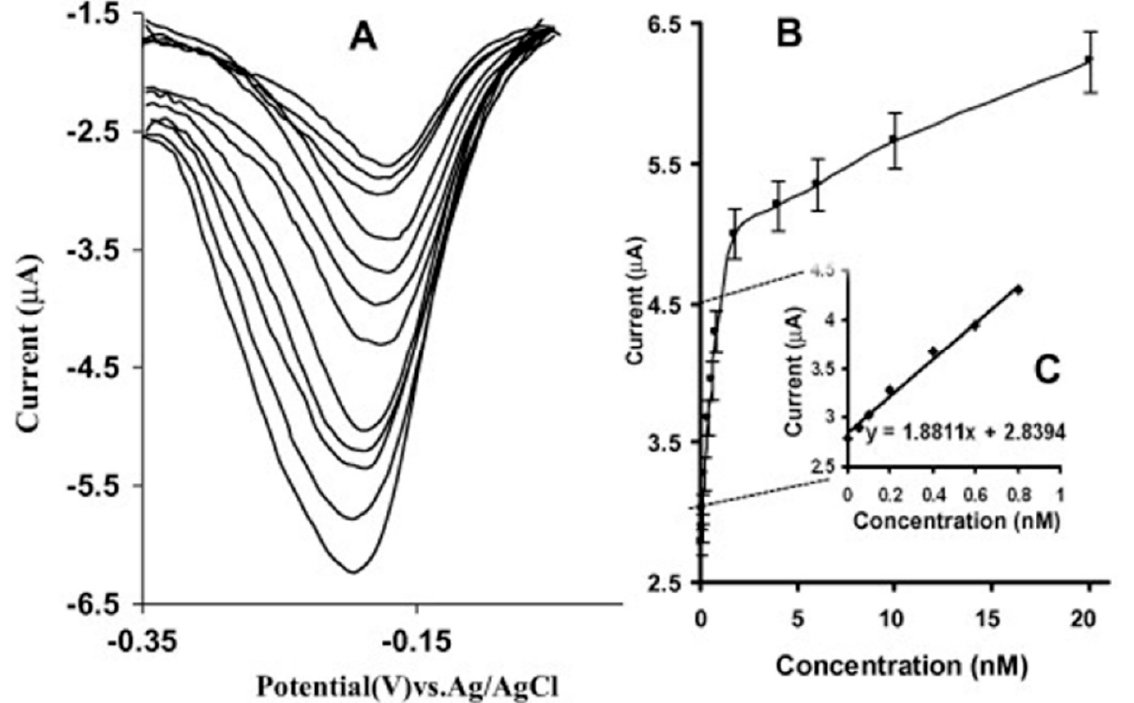
Figure 5. ( A ) Differential pulse voltammograms of SA-HRP-biotin aptamer/IgE/NH 2 aptamer/MWCNT/IL/Chit/GC electrode after incubation for 15 min with different IgG concentrations (from inner to outer: 0, 0.05, 0.1, 0.2, 0.4, 0.6, 0.8, 2, 4, 6, 10, and 20 nM) in PBS (0.1 M, pH 7.4) containing 2.5 mM H 2 O 2 . ( B ) Plot of current response vs. IgE concentration. ( C ) The linear portion of the current versus IgE concentration response. Reprinted with permission from reference [58]. Copyright, 2014 Elsevier.